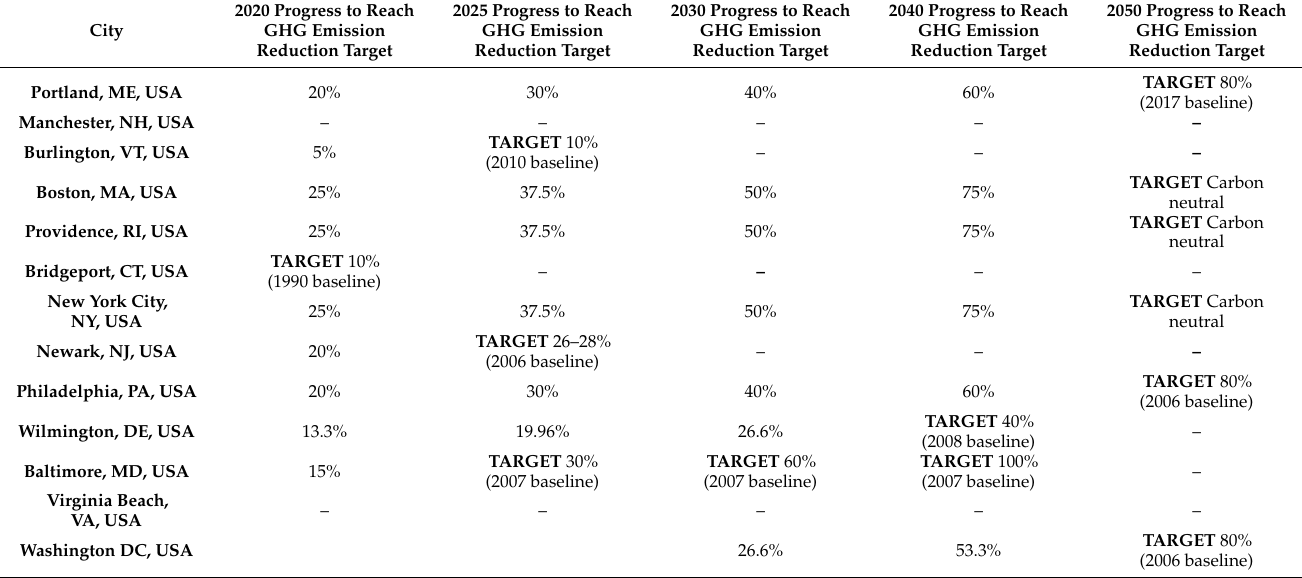
Table 4. For each of the 13 cities across the BosWash corridor, GHG emission reduction goals and the year by which these targets will be achieved are outlined and benchmark goals are pro-rated to compare progress requirements for each city from 2020 to 2050 [109–121]. Many of the cities have a target emission reduction deadline in 2050, defining the upper bound for pro-rating progress. Included are the baseline emission values for each city for which to base the percentage